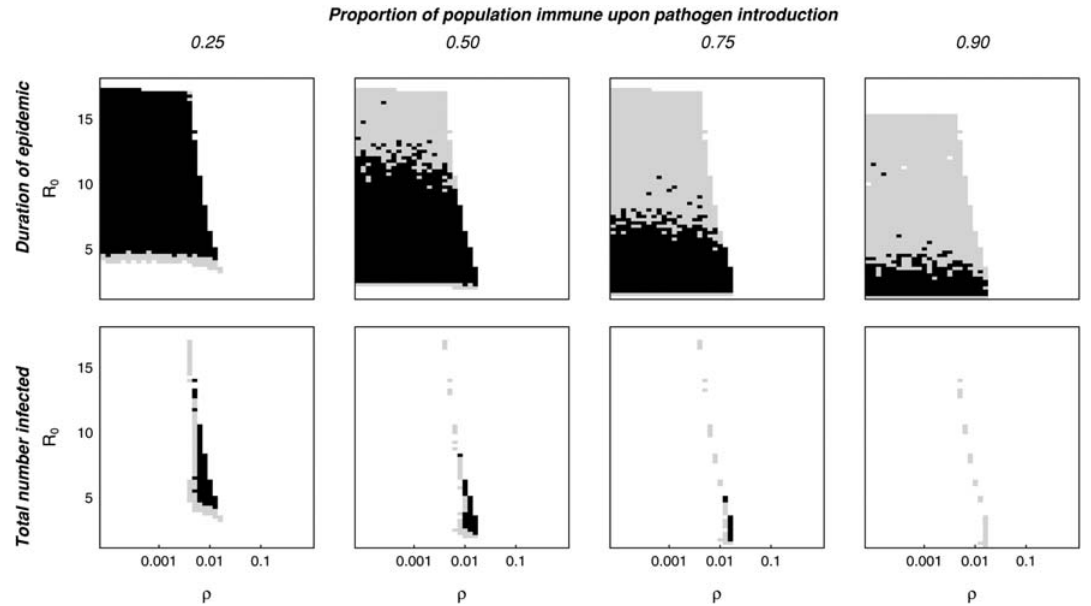
Figure 2. Stochastic demonstration of epidemic enhancement in partially immune populations. Each plot is a comparison of the outcome of the runs starting with a particular immunity level to the 90 th percentile of runs in a naı¨ve population. Black spaces show where enhancement occurs; that is, . 15% of epidemics in partially immune population are longer (top row) or larger (bottom row) than the 90 th percentile of epidemics in a naı¨ve population. Grey spaces show the area where 5–15% of the epidemics in the partially immune population are longer or larger than the 90 th percentile of epidemics in a naive population (so vaccination has little or no effect in either direction). The simulation was run 500 times for introduction into a naı¨ve population for each set of parameter values, and these runs were used to determine the 90 th percentile for epidemic duration and size; the pathogen was considered to persist if it remained in the population for $ 300 disease generations. The simulation was then run 500 times for each of the levels of initial population immunity (25%, 50%, 75%, 90%) in the portion of parameter space for which the pathogen did not persist in the naı¨ve population. The total population size is N =50,000.